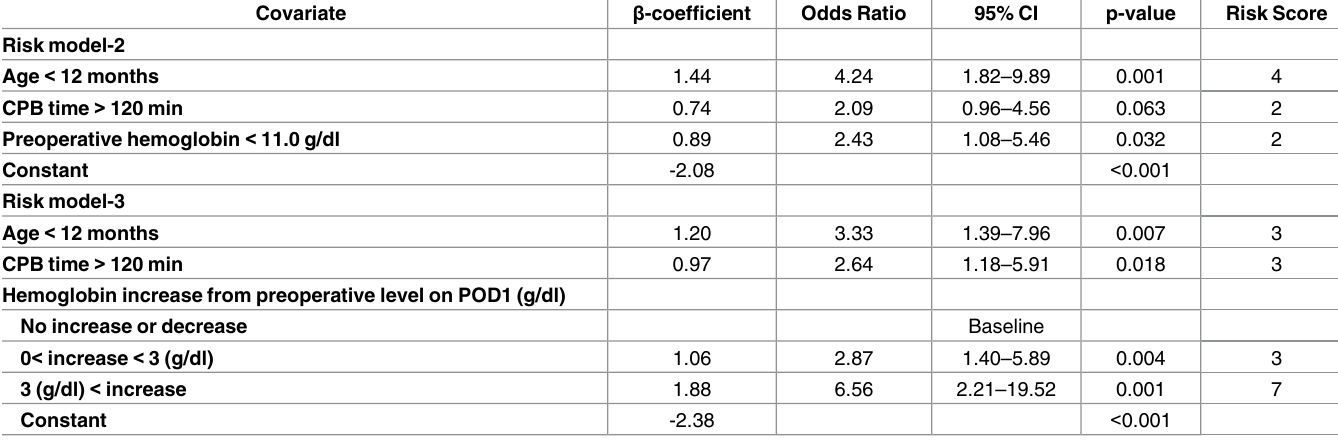
Table 3. Multivariable analysis of predictors for postoperative acute kidney injury.